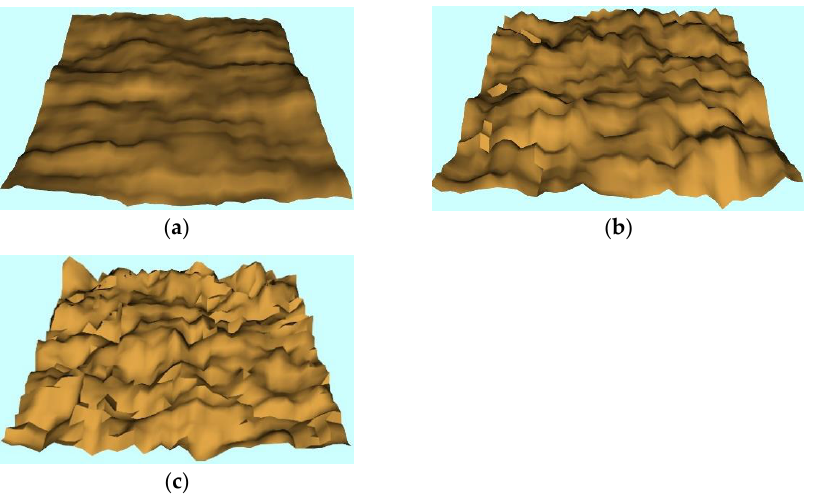
Figure 1. Three 1.2 km simulated rugged terrain scenes with different mean slopes and normal distribution of elevations (( a ) α = 9.13 ◦ ; ( b ) α = 22.83 ◦ ; and ( c ) α = 33.40 ◦ ).